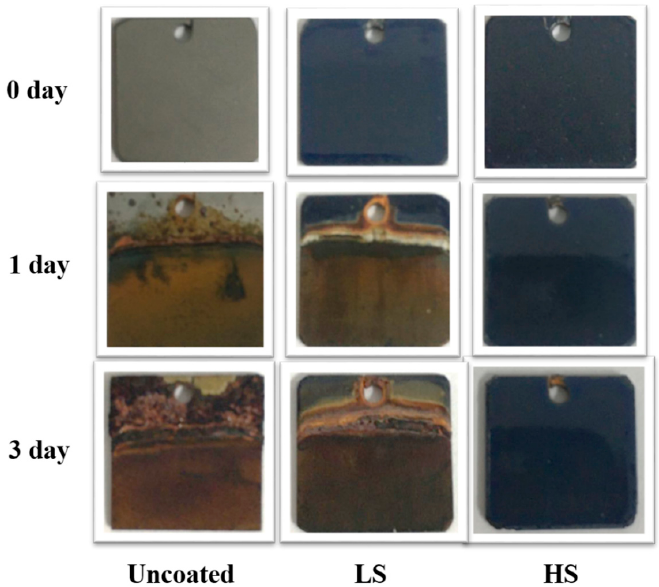
Figure 2. Macro images of the uncoated, LS and HS samples before and after corrosion in a 0.5 M HCl solution at 30 °C for different days.